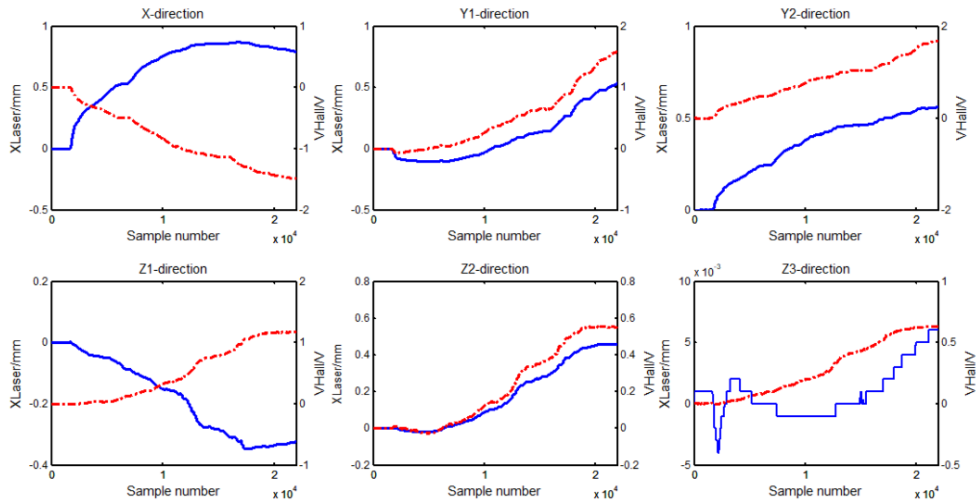
Figure 7. The laser sensors output displacement (blue) and the Hall sensors output voltage (red) sampled by the host computer.